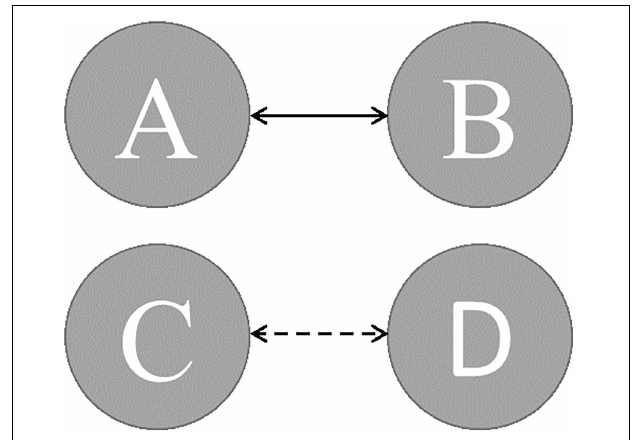
FIGURE 3 | The expected transition probabilities in AD and PD patients (dashed line presents transition probabilities were lower; solid line presents transition probabilities were greater).